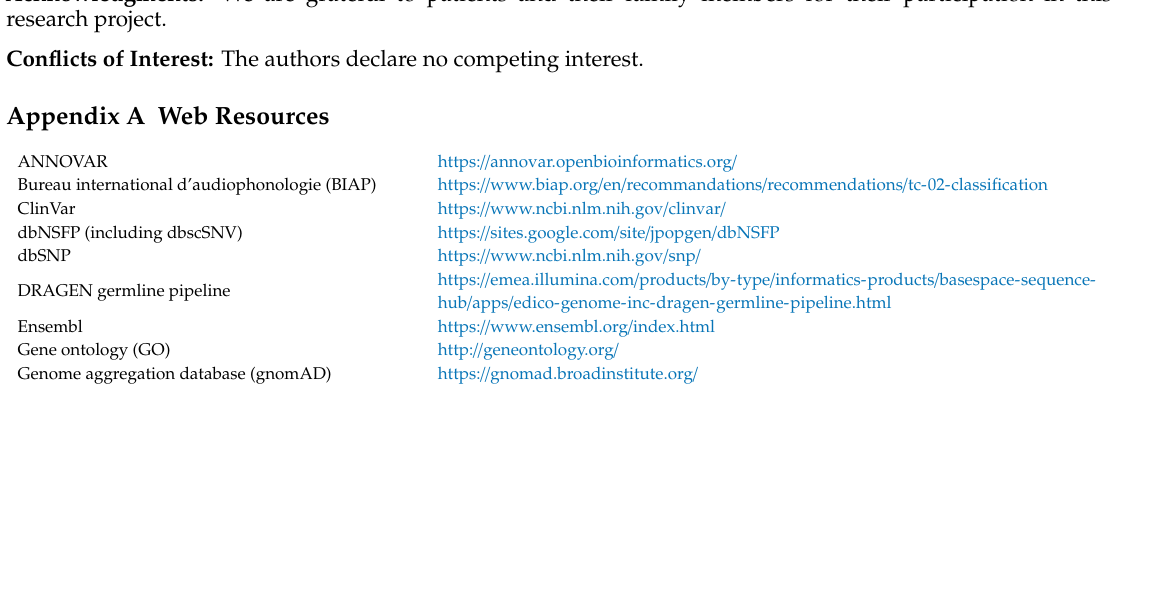
Table S1: Demographic and clinical characteristics of isolated NSHI cases screened for the identified CLIC5 pathogenic variants. Mean age = 10.92 ± 4.84 (3–31) years, Table S2: Description of pathogenic variants identified in CLIC5 , Table S3: Synonymous likely benign variants identified in the CEP250 gene, Table S4: Model parameters before and after refinement showing improvement in protein model qualities, Figure S1: Secondary structure prediction of CLIC5 using the 251 amino acids isoform (NM_016929.5). Boxes indicate positions of di ff erence between the wild-type (CLIC5A:p.75L) and mutant (CLIC5A:p.75P). Red boxes show loss of the fourth